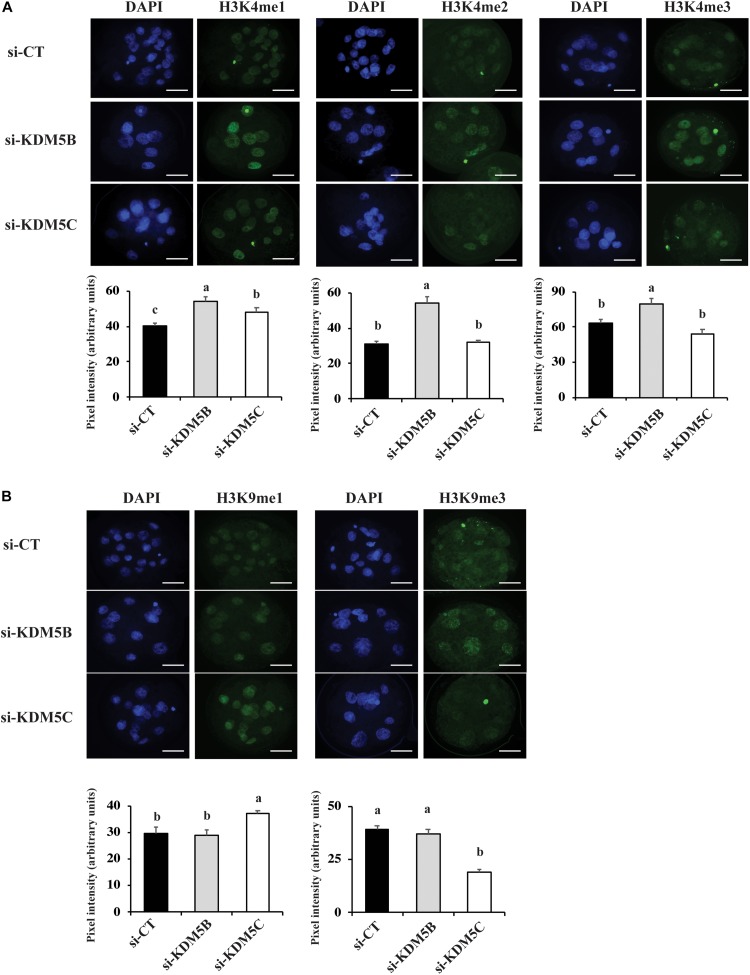
Detection of H3K4 and H3K9 methylation by immunofluorescence on Day 5 PA embryos derived from oocytes injected with si-CT, si-KDM5B or si-KDM5C. (A) Representative pictures and quantification of the pixel intensity for H3K4-me1, me2 and me3 staining. (B) Representative pictures and quantification of the pixel intensity for H3K9me1, me2 and me3 staining. Three independent replicates were performed and 4–6 embryos were used to quantify pixel intensities for each epigenetic mark. Different letters indicate statistical significance between treatments for each epigenetic mark (P < 0.05). Scale bars represent 25 μm.